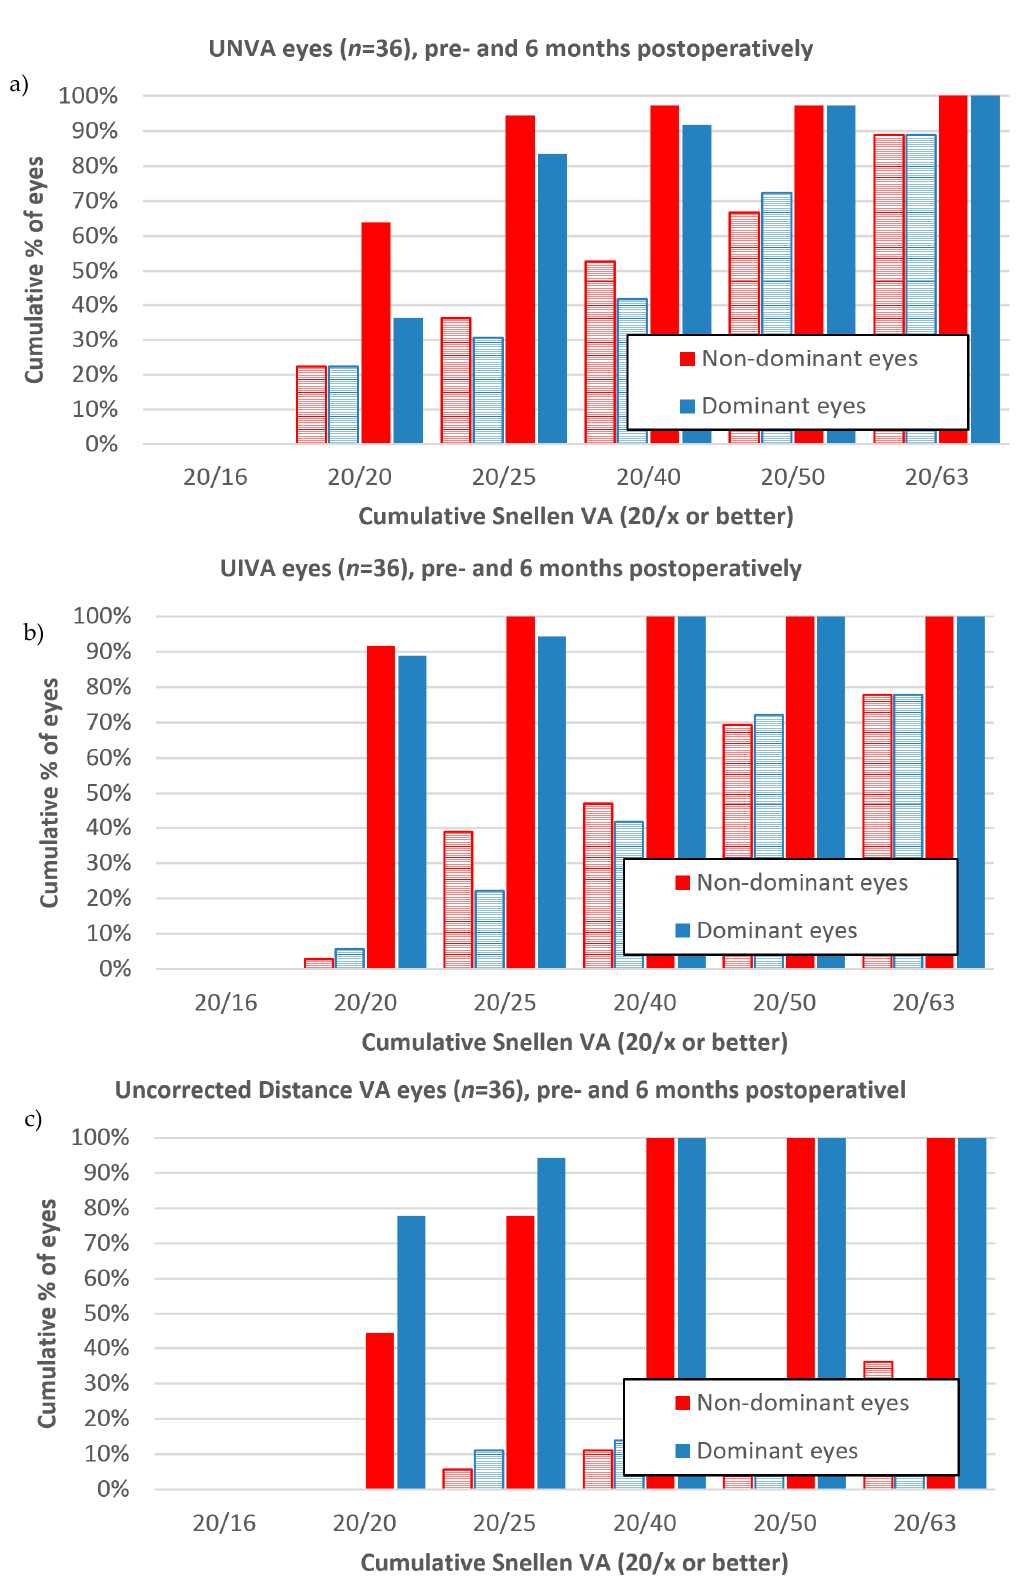
Figure 7. Cumulative percentage of subjects with 20/x dominant and non-dominant near ( a ), intermediate ( b ), and distance ( c ) visual acuity for 36 subjects. Dashed bars are preoperative, and solid bars are six-months postoperative data. Each percentage value is to be interpreted as 20/x vision or better.